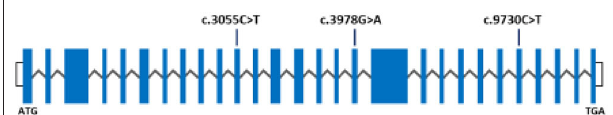
FIGURE 1 | Schematic representation of the ASPM gene on 1q31, showing exons (blue rectangles) and introns (black zigzag lines). White blocks represent the location of the untranslated regions. ASPM is the main driver of primary microcephaly. The previously known mutations c.3055C > T, c.3978G > A, and c.9730C > T were found in this study.